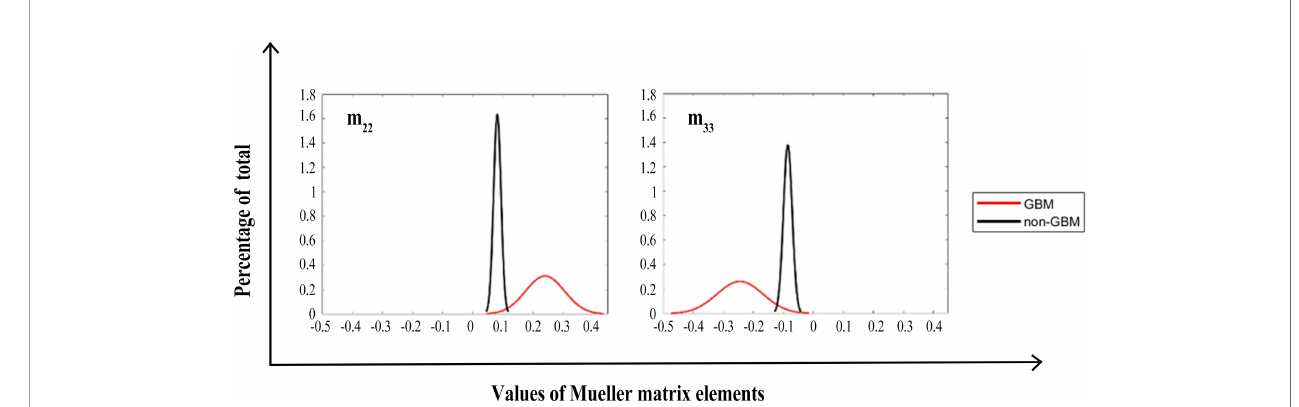
FIGURE 7 | FDH distributions of diagonal Mueller matrix elements of GBM (red lines) and non-GBM tissue (black lines).